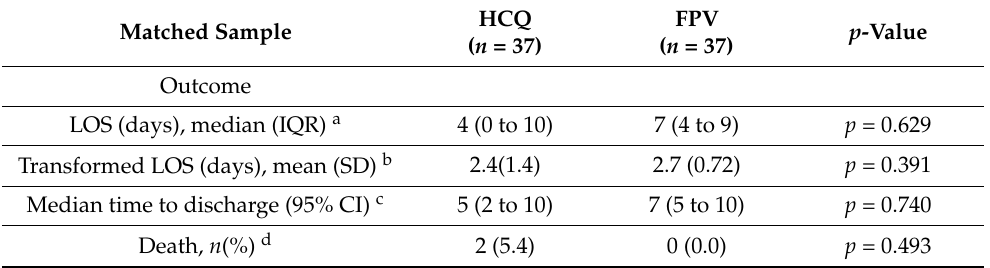
Table 2. Clinical outcomes in the matched sample. HCQ FPV p -Value Matched Sample ( n = 37) ( n = 37) Outcome LOS (days), median (IQR) a 4 (0 to 10) p = 0.629 Transformed LOS (days), mean (SD) b 2.4(1.4) 2.7 (0.72) p = 0.391 Median time to discharge (95% CI) c Death, n (%) d 2 (5.4) 0 (0.0) p =